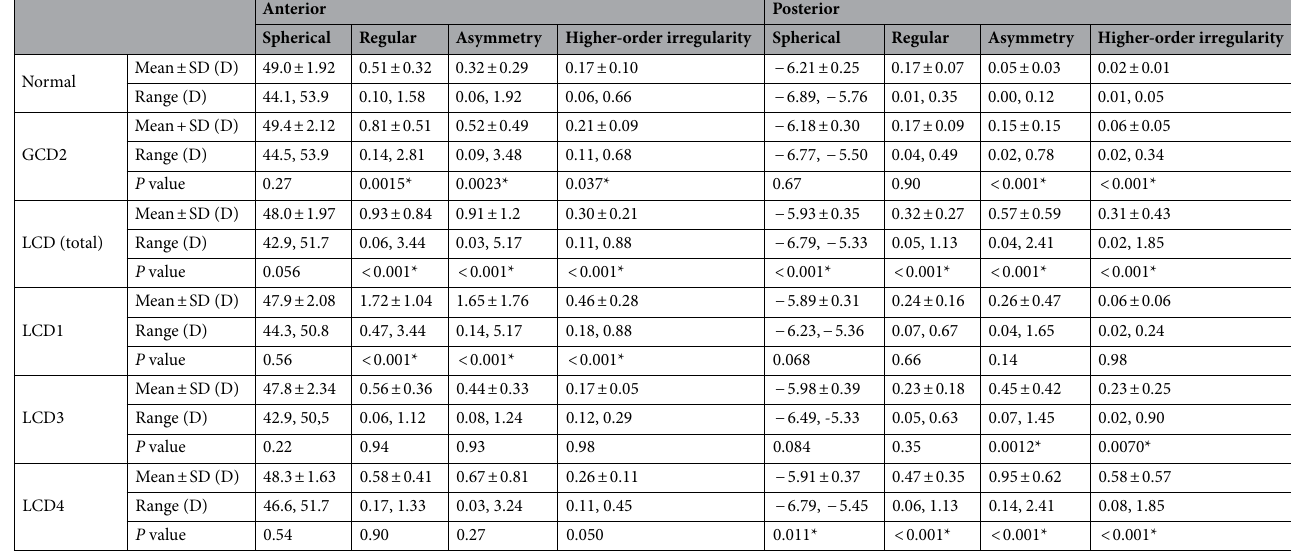
Table 2. Each Fourier component. SD : Standard deviation, GCD2 : Granular corneal dystrophy type 2, LCD : Lattice corneal dystrophy, LCD1 : Lattice corneal dystrophy type 1, LCD3 : Lattice corneal dystrophy type IIIA, LCD4 : Lattice corneal dystrophy type IV. p values were calculated using the linear mixed effect model. *, p value < 0.05.